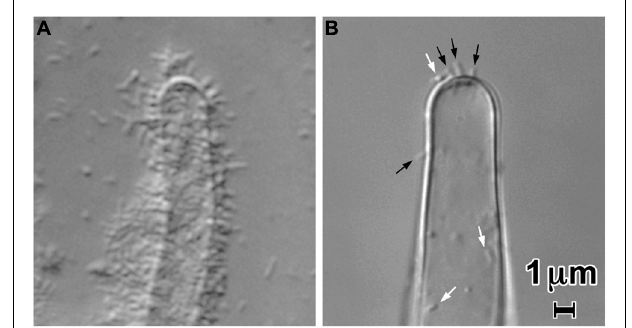
FIGURE 2 |Attachment of A. tumefaciens strain C58 to tomato root hairs in a 1/10 dilution of MS medium containing a 1/20 dilution ofAB minimal medium (A) and in 60 mM CaCl 2 , 7 mM sodium acetate, and 247 mM mannitol pH 5.8 (B). Note the large decrease in attachment in the presence of the CaCl 2 -containing medium Laterally attached bacteria are visible at the white arrows in (B) ; polarly attached bacteria are indicated by the black arrows. Approximately 10 6 bacteria per ml were incubated with cut tomato roots for 24